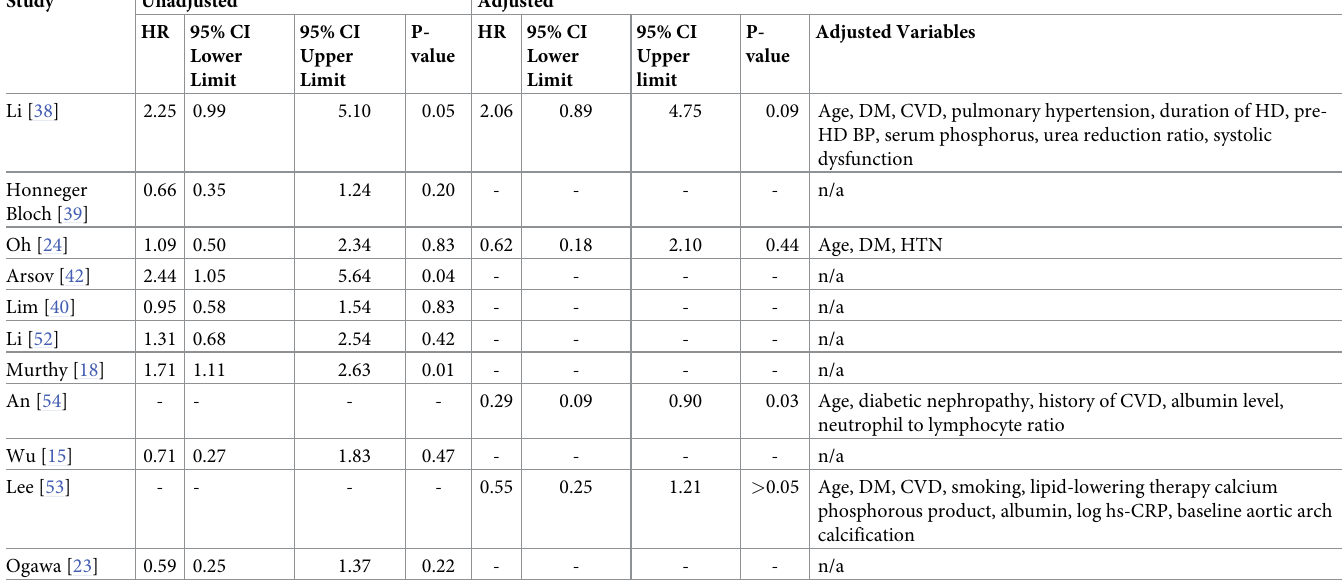
After combining the reported and calculated risk estimates (HR/RR) in a random-effects meta-analysis, the overall risk estimate indicated that men with CKD were marginally at higher risk of cardiovascular mortality compared to women with CKD (RE 1.13, 95%CI 1.03–1.25), with moderate heterogeneity (I 2 = 35.89%; see Fig 4).